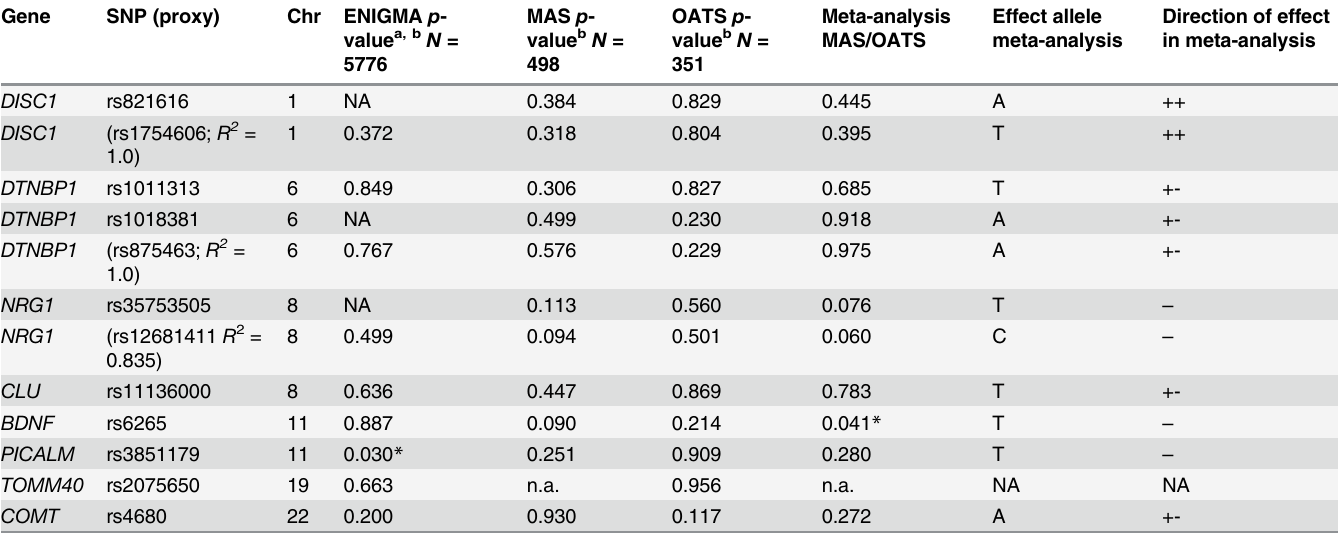
Table 4. HV association of genetic variants previously identi fi ed as having relevance to HV (Stein et al. 2012) in ENIGMA, Sydney MAS, OATS and a meta-analysis of MAS/OATS. Gene SNP